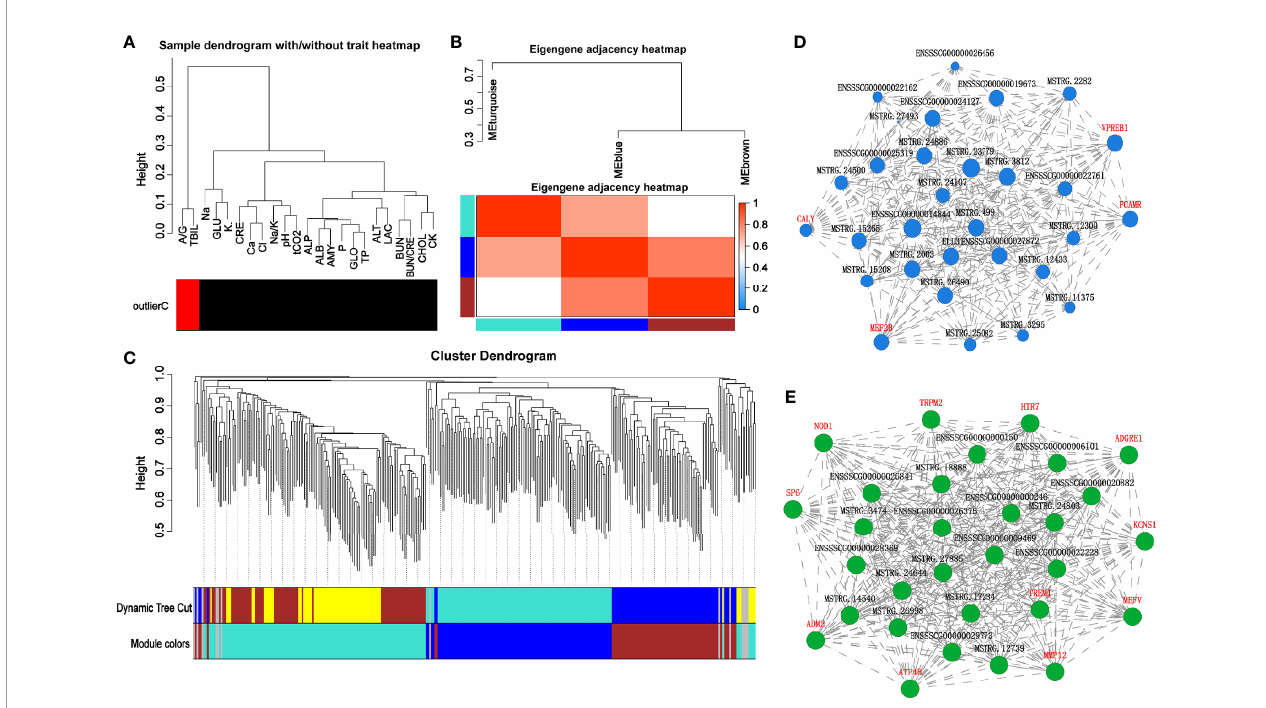
FIGURE 11 | Correlation analysis of heat-stressed pig colonic transcriptome and serum biochemical indicators. (A) WGCNA cluster analysis; (B, C) WGCNA modular analysis; (D, E) WGCNA module related gene interaction